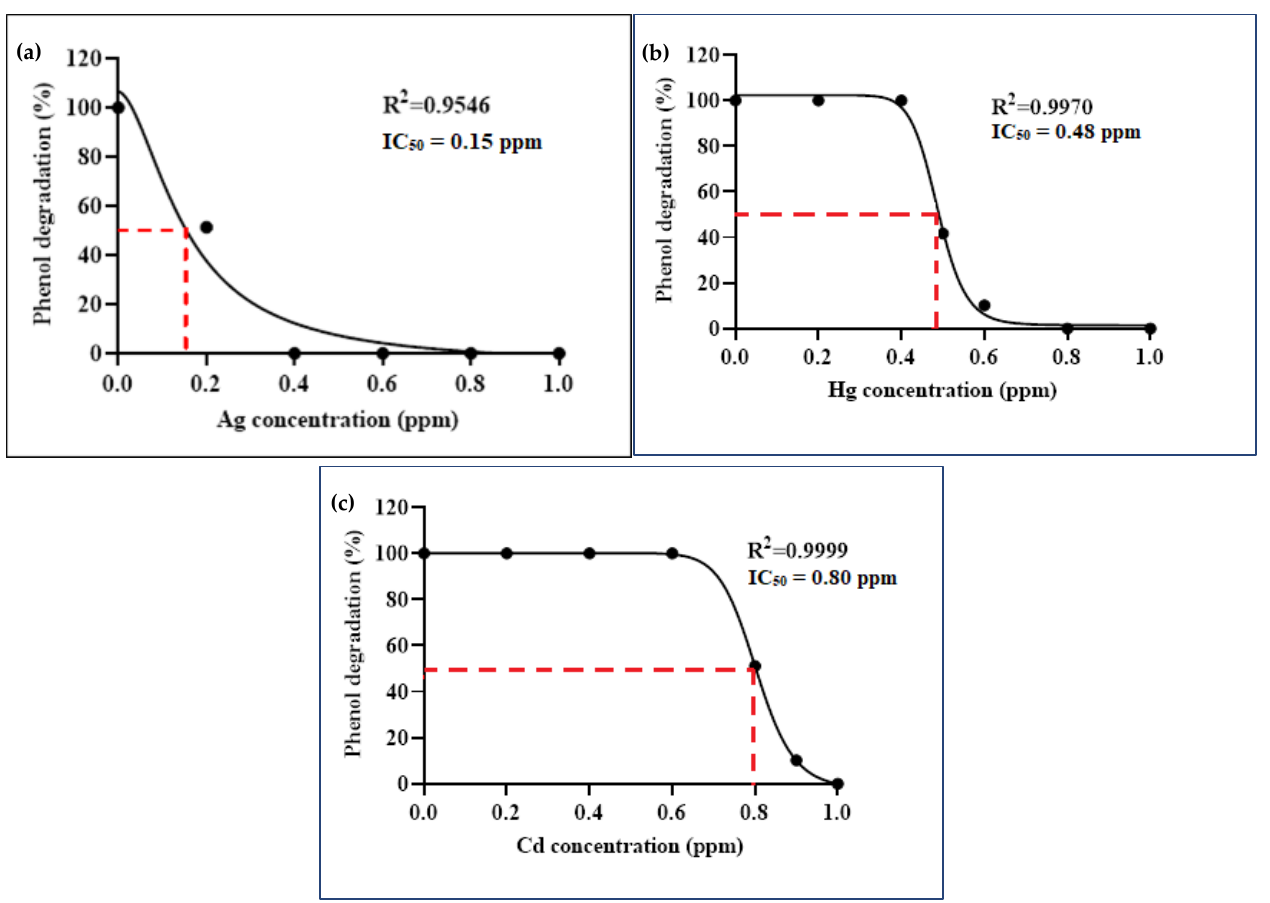
Figure 11. The influence of exposure to different concentrations of Ag, Hg and Cd on phenol deg- radation (solid line) and the growth (dotted line) of the binary consortium.